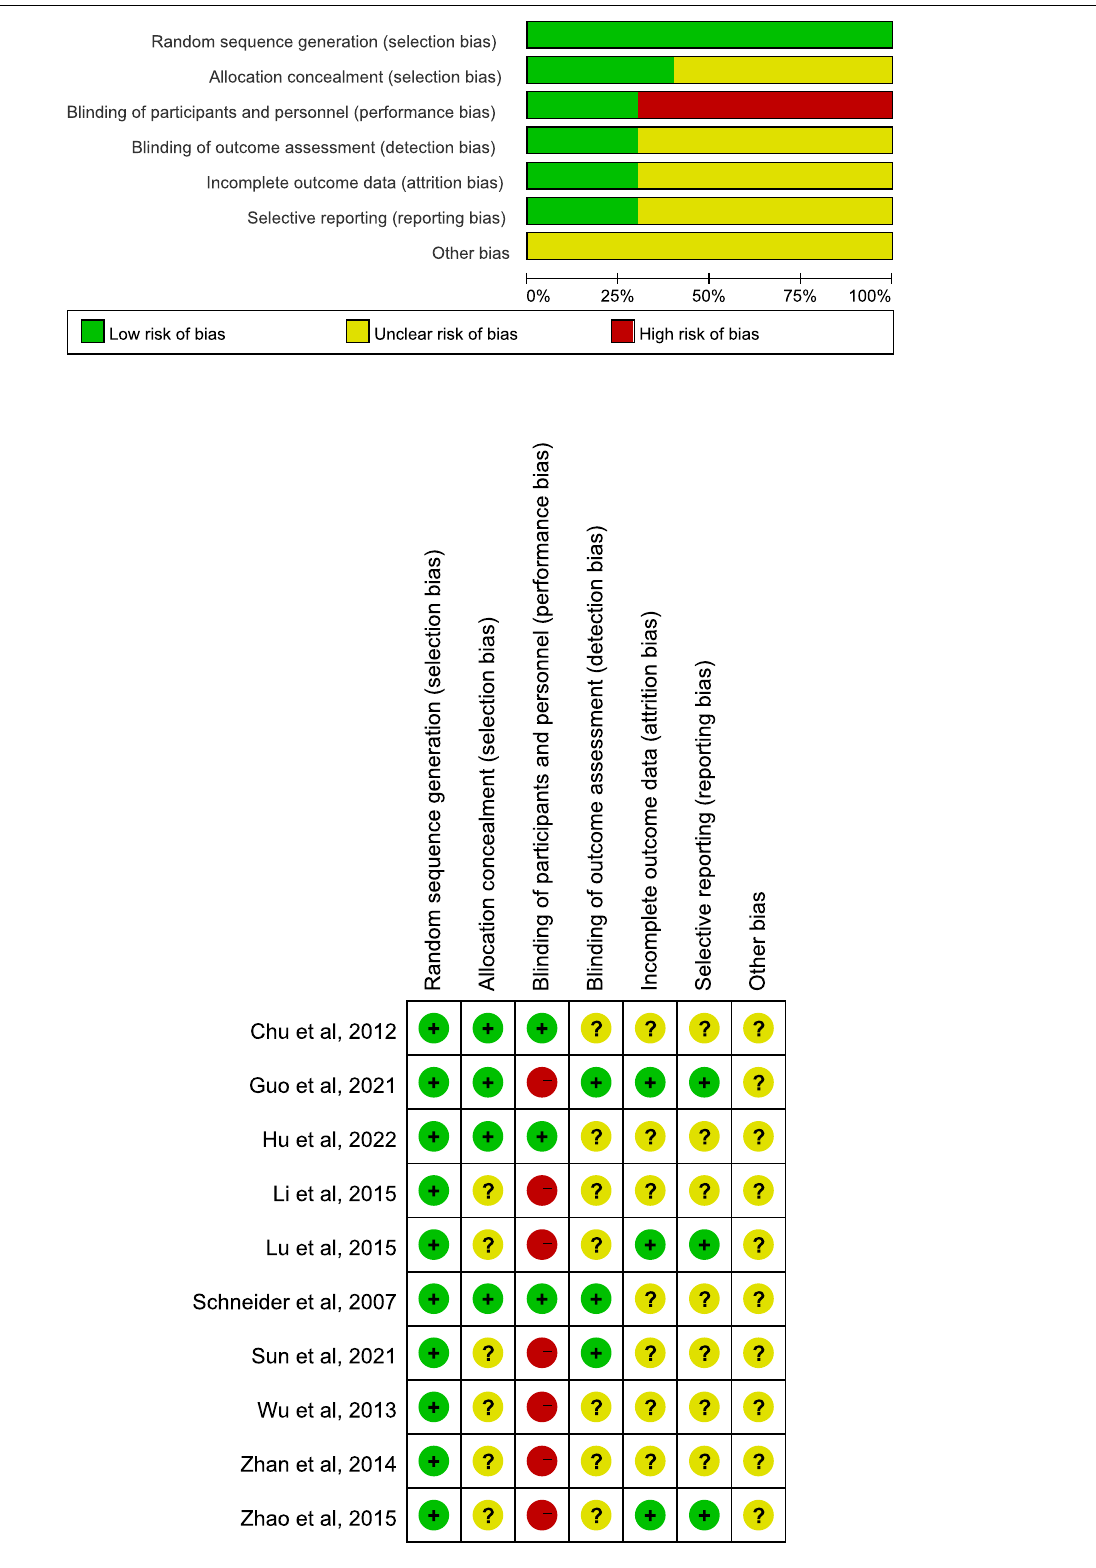
FIGURE 3 | Risk of bias graph and summary of included studies.